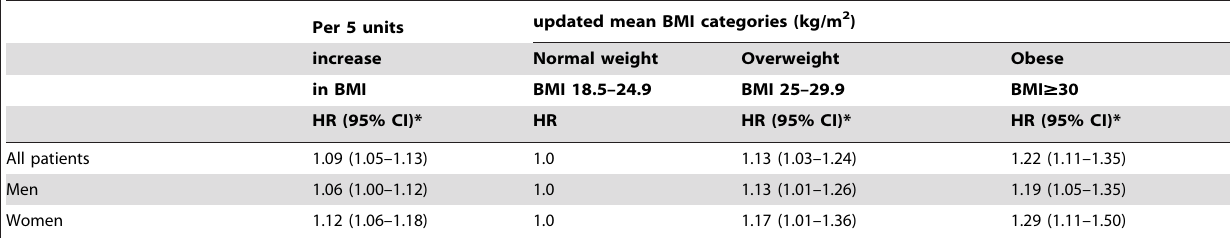
Table 3. Hazard ratios (HR) with 95% confidence intervals (CI) for all cancer, in overweight or obese patients compared with normal weight patients as reference, classified based on updated mean BMI values, given in all patients with type 2 diabetes and by gender.